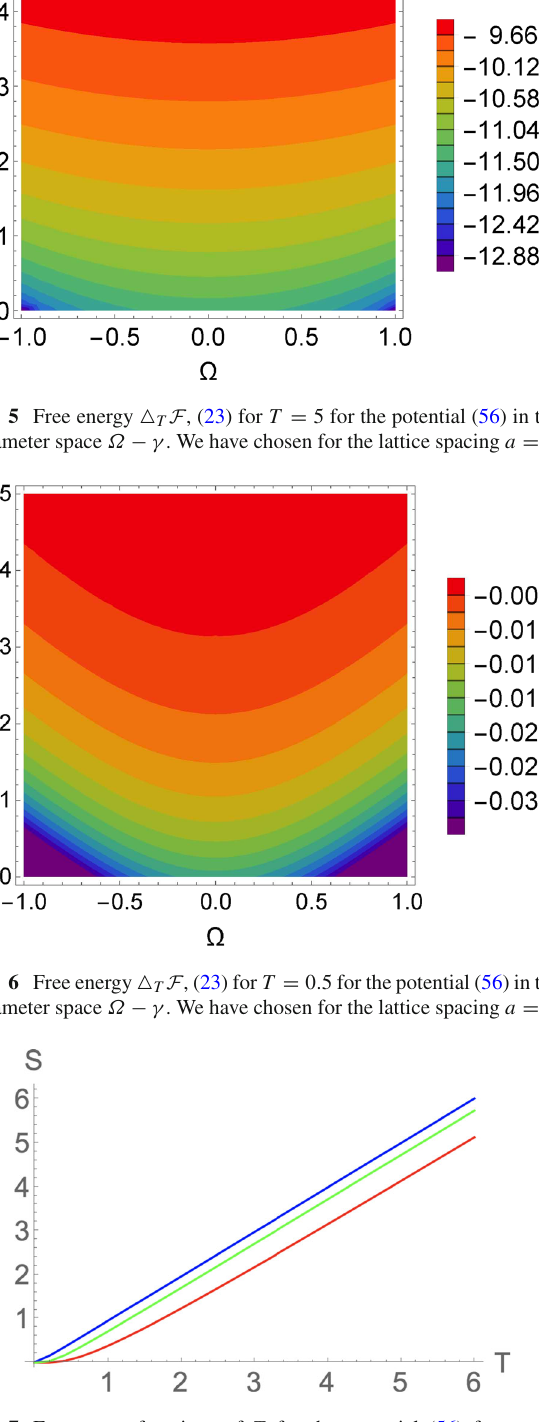
Fig. 7 Entropy as functions of T for the potential (56) for w 0 = 0 . 1 ,w 1 = 5 (blue), w 0 = 8 ,w 1 = 0 (red), w 0 = 3 ,w 1 = 2 (green). We have chosen for the lattice spacing a =